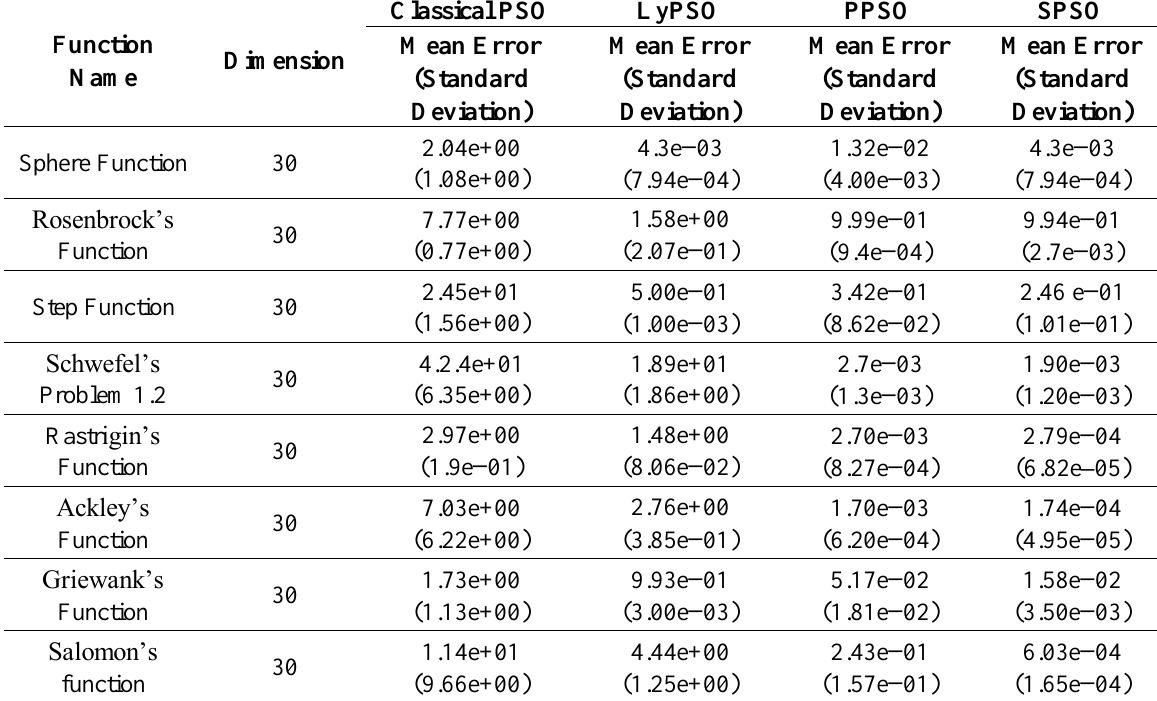
Table 6. Mean error and standard deviation over the benchmarks.